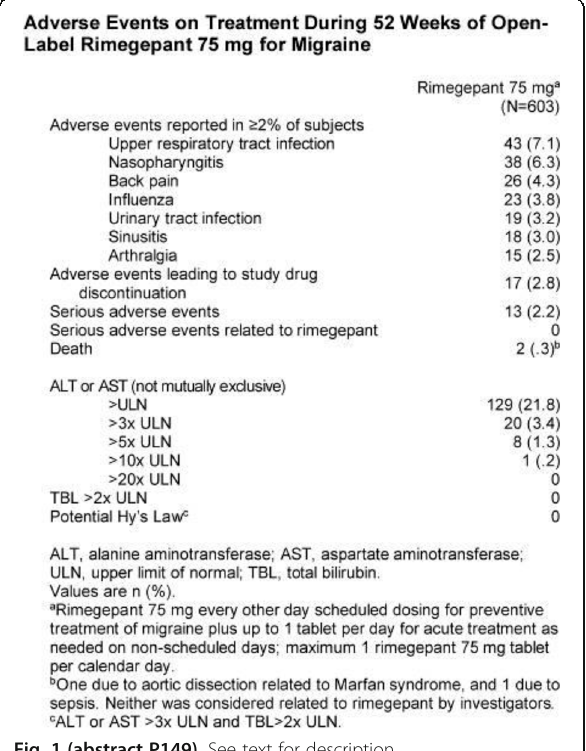
Fig. 1 (abstract P149). See text for